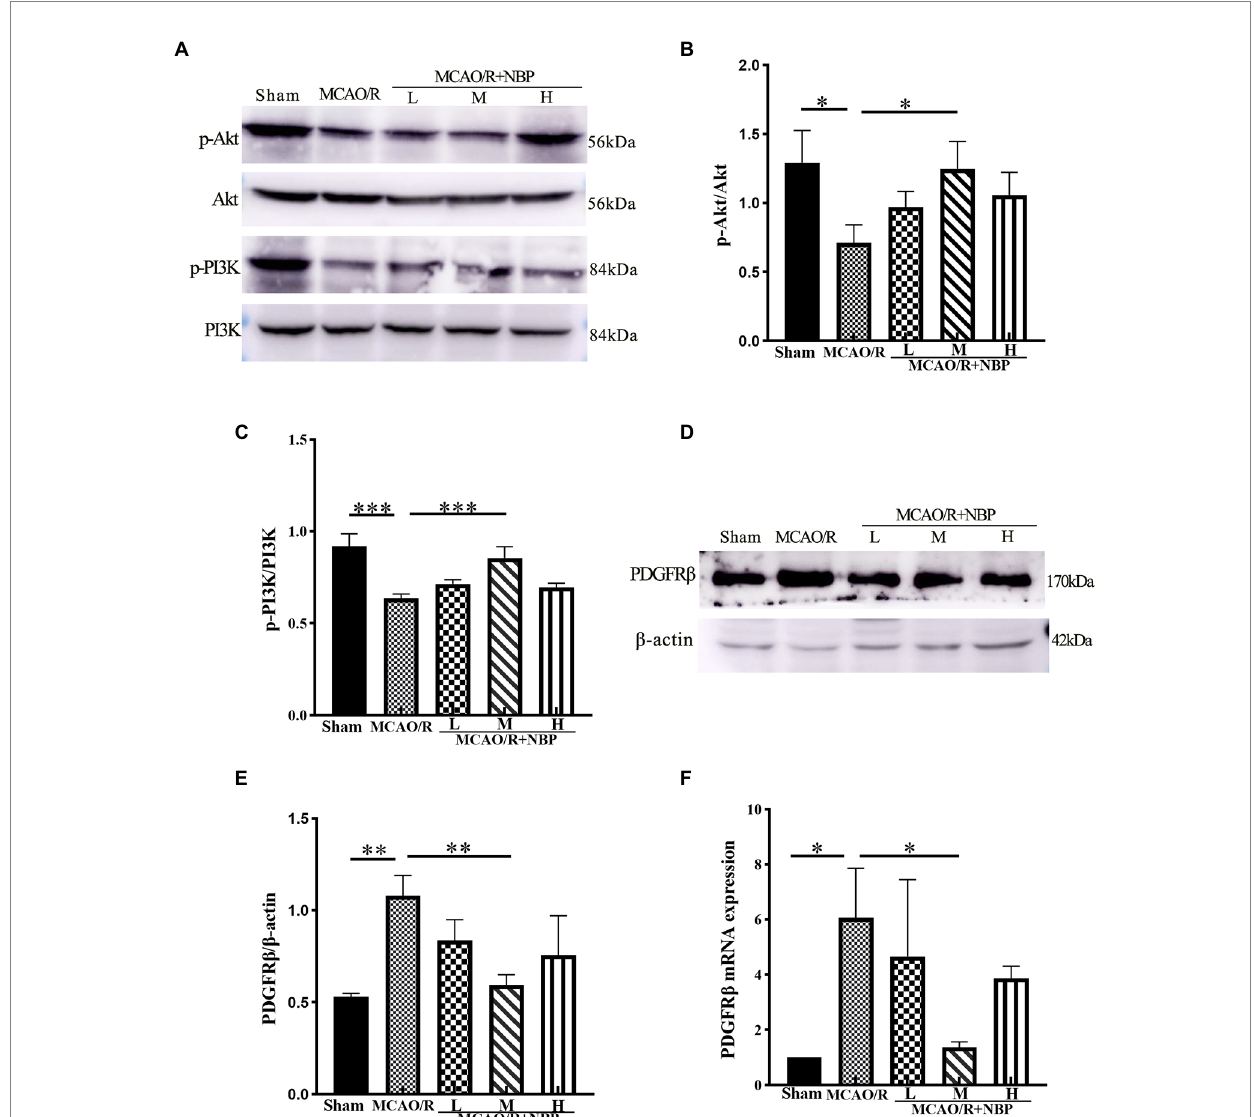
FIGURE 5 Western blot and PCR of BBB signal protein. (A) Representative western blot image of p-Akt, Akt, p-PI3K, and PI3k. (B,C) The expression ratio of p-Akt/ Akt and p-PI3K/PI3k is quantified by image J software and is represented as a histogram. (D) Representative western blot image of PDGFR β . (E) The expression ratio of PDGFR β / β -actin is quantified by Image J software and is represented as a histogram. (F) PCR for PDGFR β levels within cerebral cortex tissues. BBB, the blood–brain barrier; PCR, real-time polymerase chain reaction. * p < 0.05, ** p < 0.01, *** p < 0.001. The values represent the mean ± SD, n =